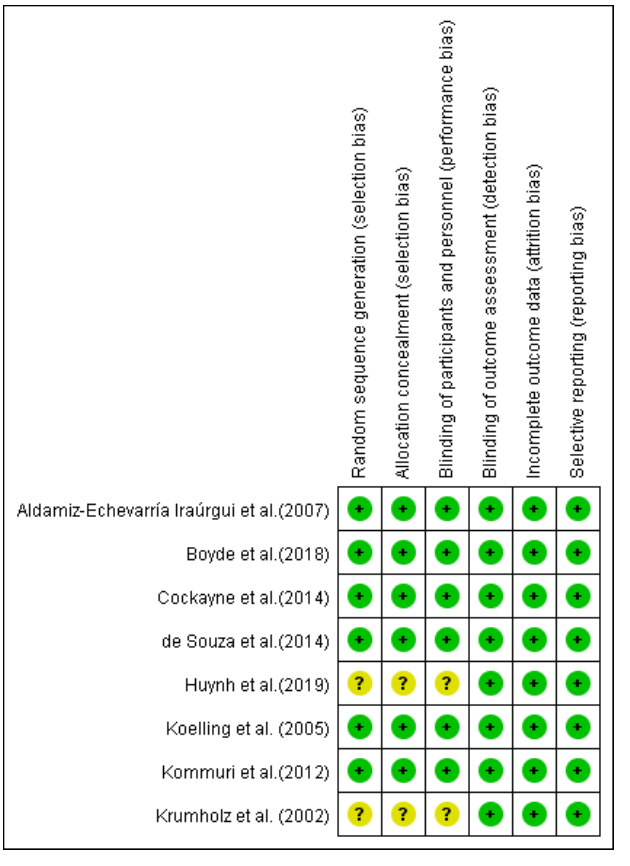
Figure 2. Risk of bias graph.